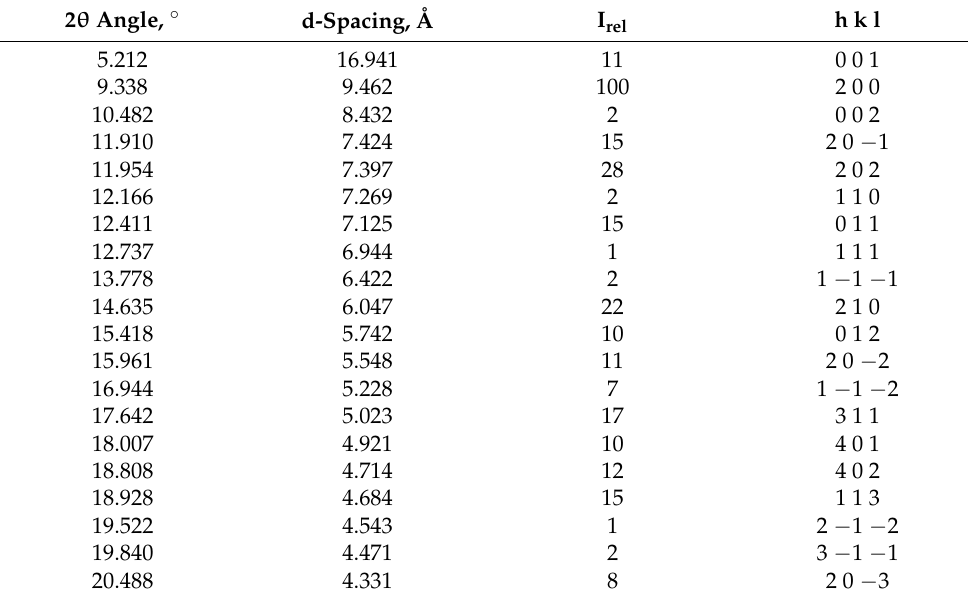
Table 7. List of observed 2 θ angles, d-spacings, and relative intensities, jointly with reflection indices, for Eltrombopag Form